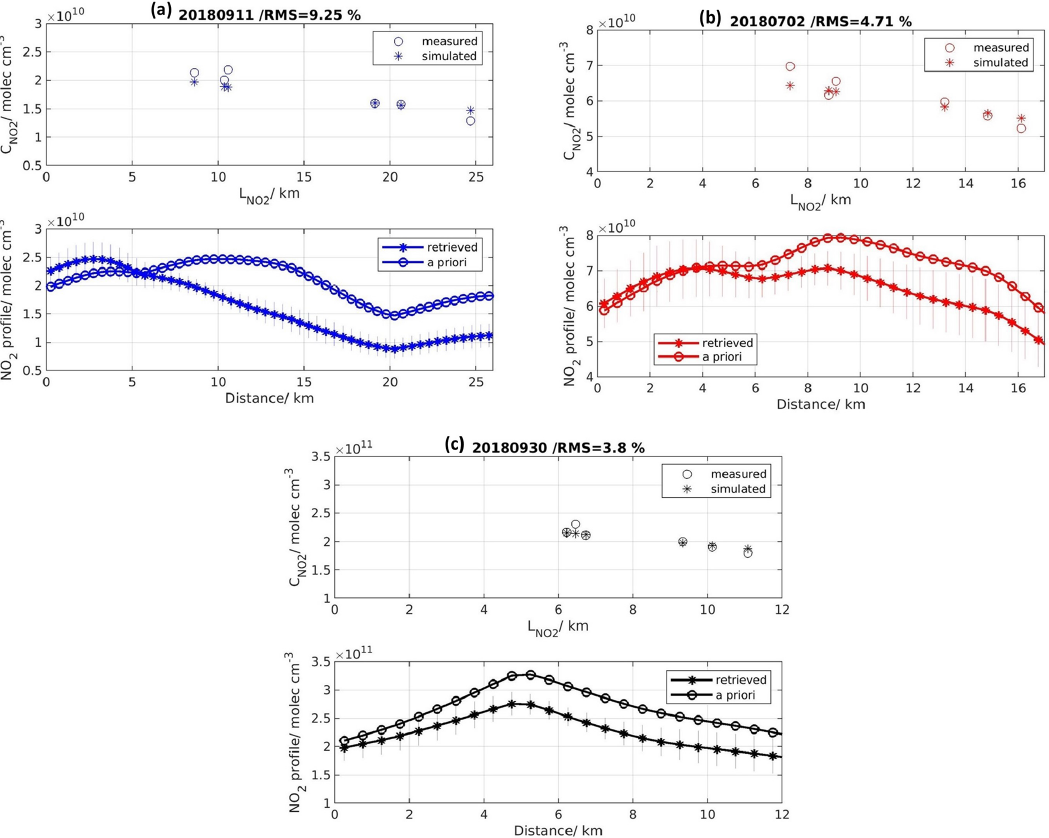
Figure 13. Measured and retrieved NO 2 near-surface concentrations (upper panels in a , b , and c ) at the six different wavelengths (i.e., horizontal distances) as a function of the estimated horizontal distances and (lower panels in a , b , and c ) the retrieved NO 2 near-surface horizontal profile and a priori profile. The panels correspond to (a) 11 September 2018 at 12:91UTC with a 265 ◦ azimuthal direction, (b) 2 July 2018 at 10:42UTC with a 25 ◦ azimuthal direction, and (c) 30 September 2018 at 07:96UTC with a 167.5 ◦ azimuthal